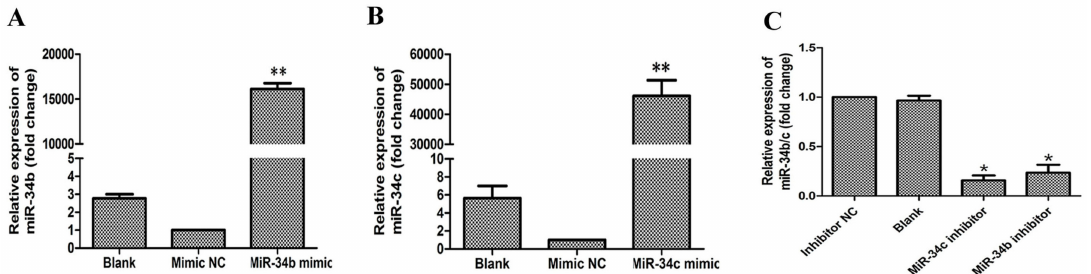
Figure 5. ( A , B ) Relative expression of miR-34b and miR-34c in PC3 cells transfected with miR-34b/c mimic or mimic negative control (NC) or without transfection (Blank) by qRT-PCR analysis. ** p < 0.01 vs. mimic NC or blank group; ( C ) qRT-PCR analysis showing the relative expression of miR-34b and miR-34c in DU-145 cells transfected with miR-34b/c inhibitor or inhibitor NC or without transfection (Blank). * p < 0.05 vs. inhibitor NC or blank